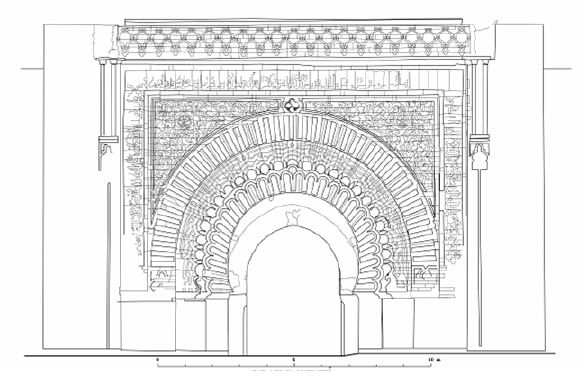
Figure 3. Elevation of Bab Agnau in Marrakech